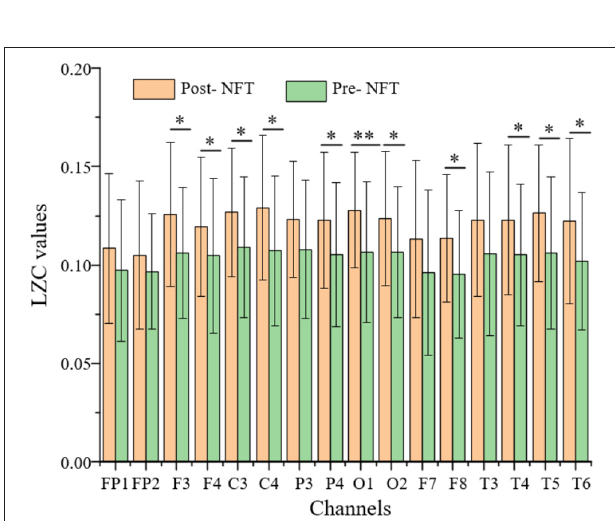
FIGURE 5 | Comparison of LZC (pre- and post-NFT). The P-value of the paired t-test is expressed as follows: * P < 0.05 and ** P < 0.01 are significant differences. The x-axis represents 16 channels, and the y-axis represents the LZC